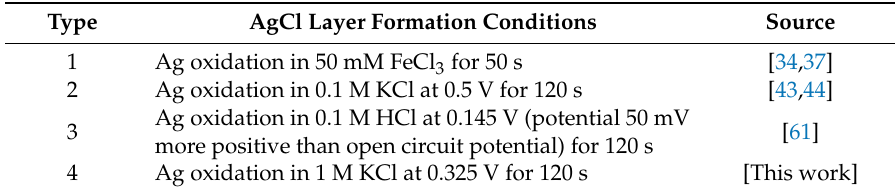
Table 4. Ag / AgCl QRE types and their formation Table 4. Ag/AgCl QRE types and their formation conditions.